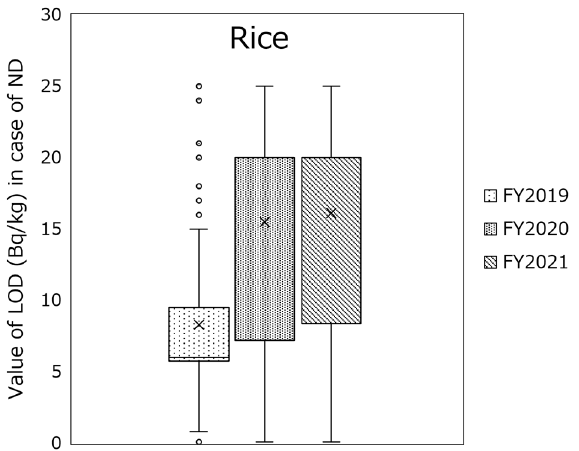
Figure 6. Box plot of the limit of detection (LOD) value in the case of not detected (ND) for rice in fiscal years (FYs) 2019–2021. fiscal years (FYs)